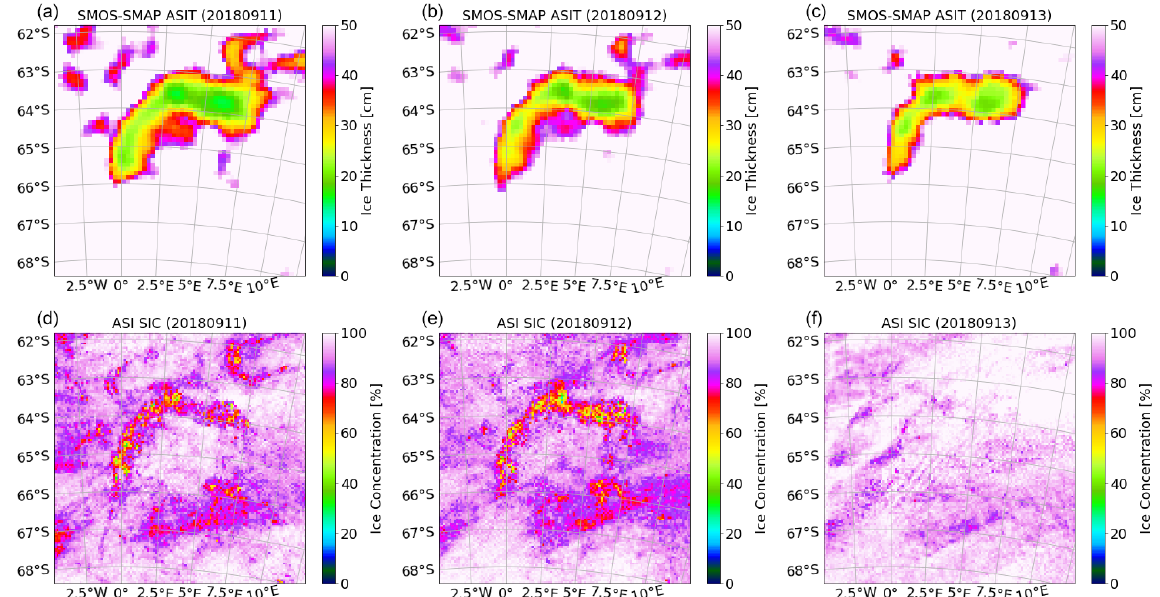
Figure 4. SMOS–SMAP ASIT (a–c) and ASI SIC (d–f) retrieval of the days during the 2018 sea ice anomaly: 11–13 September 2018.